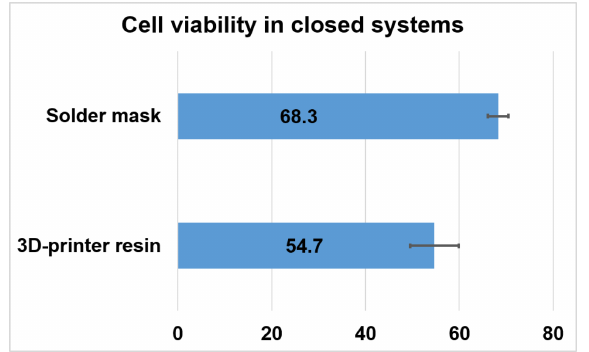
Figure 7. Biocompatibility measured in closed culture systems. Bar plot displaying the viability of retinal cells after being cultured with two different materials for 48 h in closed systems. Percentage of viable cells after culture of retinal explants in autonomous systems onto PCB, and onto a resin-based LoC. The error bars represent the standard deviation.